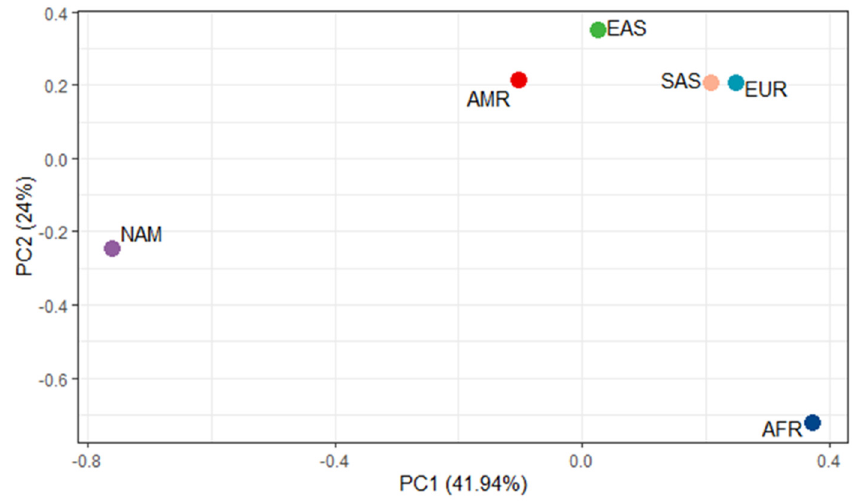
Figure 1. Principal component analysis of the 332 pharmacogenetic variants analyzed in the six populations of the present study. AFR, African; AMR, American; EAS, East Asian; EUR, European; NAM, Amazonian Amerindian; SAS, South Asian.